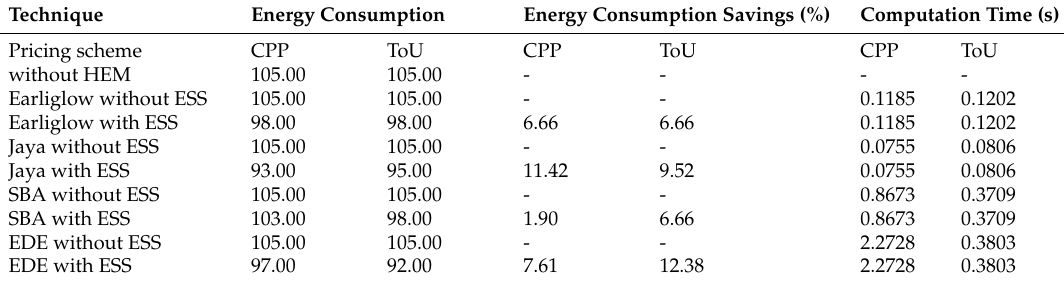
Table 5. Summary of the results for energy consumption in